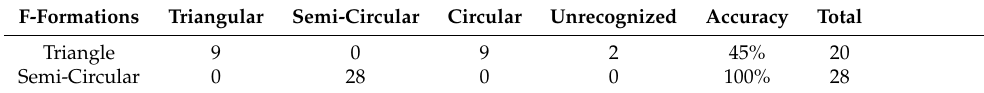
Table 11. Estimating constrained F-formations: confusion matrix and accuracy. F-Formations